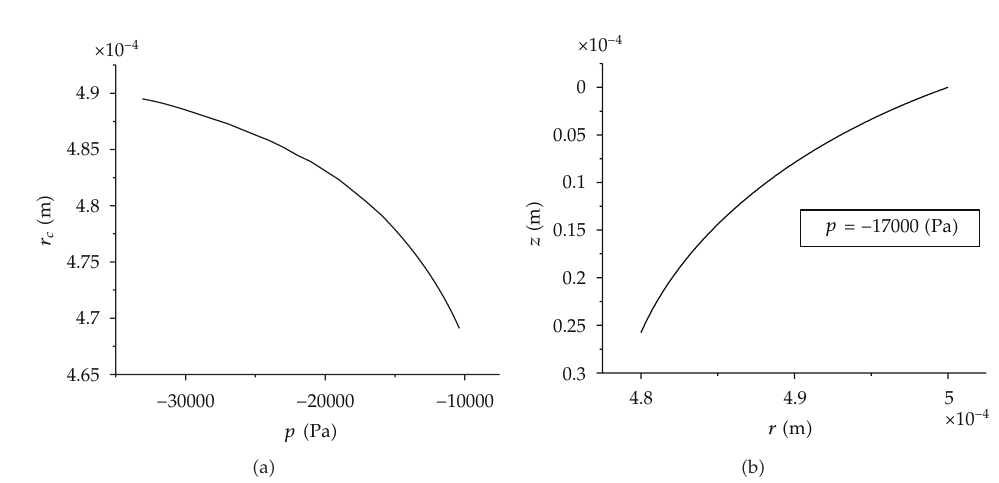
(cid:8) 0 . 523rad, n (cid:8) 1 . 1 , n (cid:2) (cid:8) 1 . 01. (cid:6) b (cid:7) The convex meridian curve Figure 5: (cid:6) a (cid:7) The function r c (cid:6) p (cid:7) for α c (cid:8) α 1 c for p (cid:8) − 17000Pa, suitable to grow microfiber with radius 4 . 8 × 10 − 4